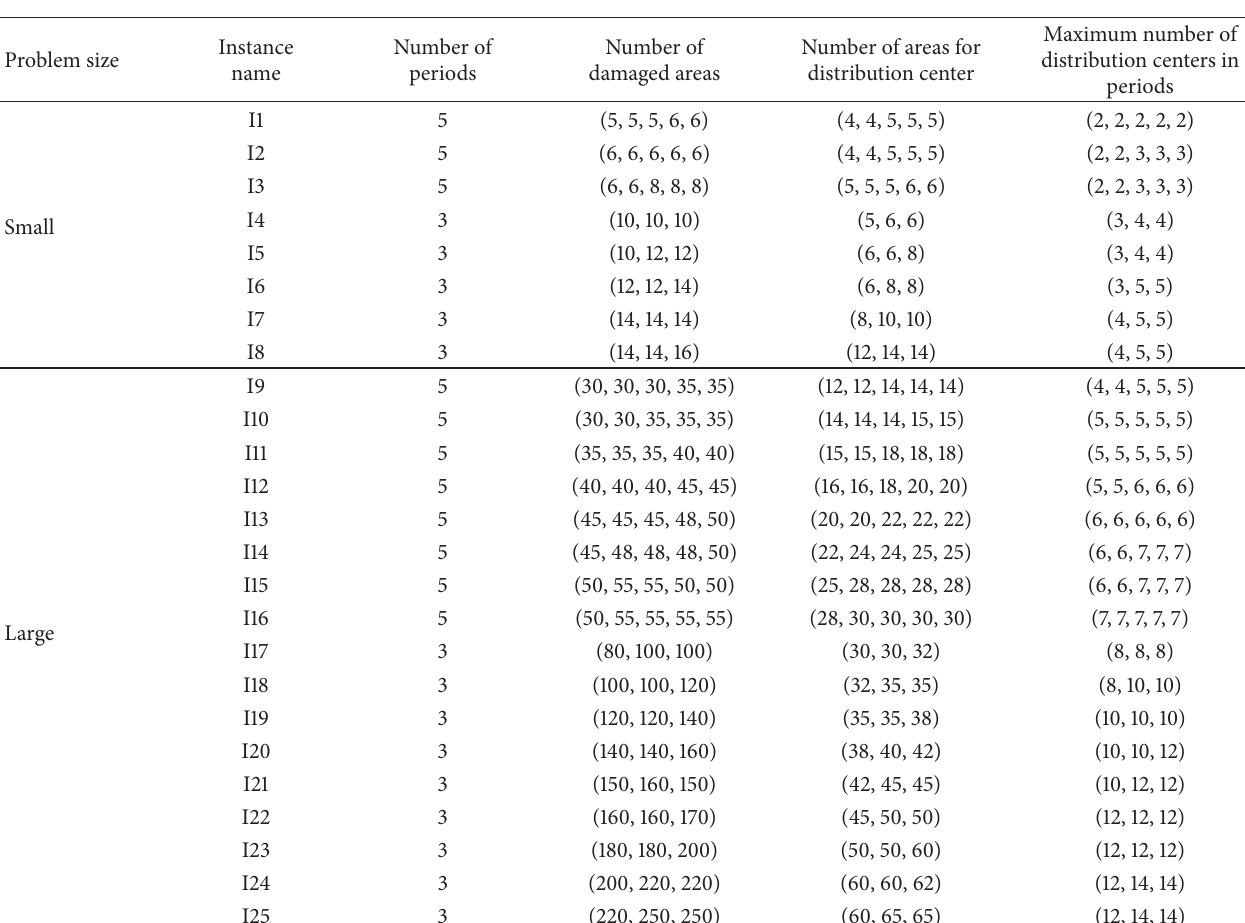
Table 4: Characteristics of